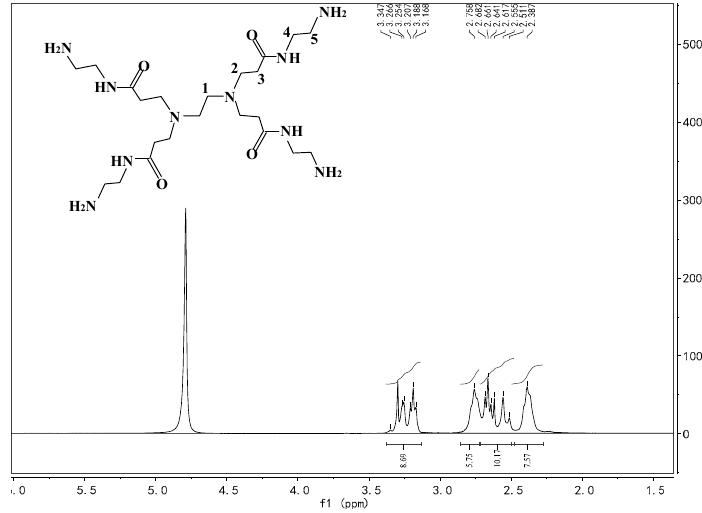
Figure A2. 1 H NMR spectrum of intermediate-2 of HBP.